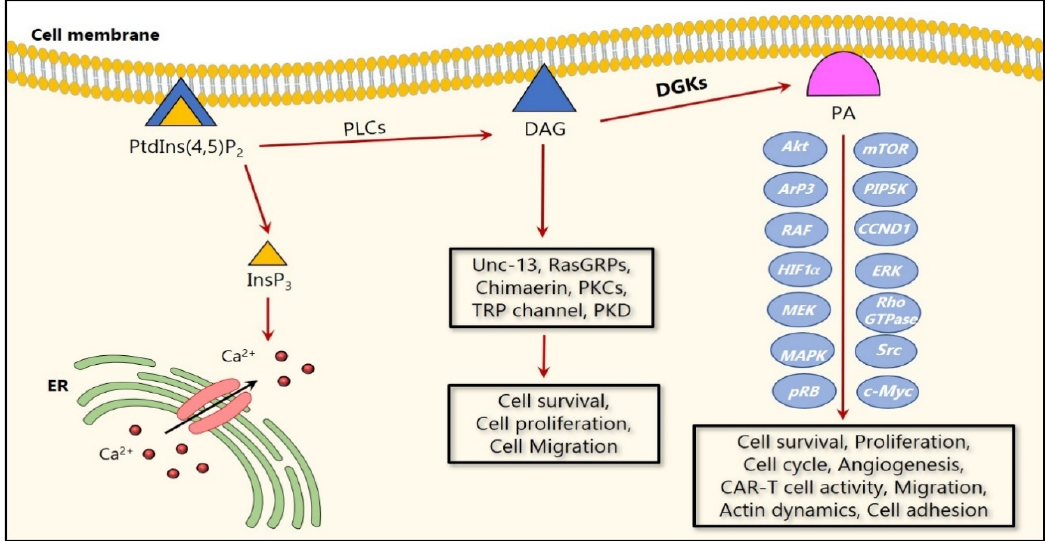
Figure 1. Cartoon representation of DGK signaling in cancer. Upon their activation, DGKs phosphorylate DAG to form PA, which results in a series of signaling events resulting from the alterations in the signaling of several molecular targets. Several studies reported that DGKs regulate cancer cell survival and proliferation via MAPK and Akt/mTOR pathways. In addition, DGKs regulate migration via the Ras/RAF/MEK/ERK pathway and the Rho GTPase family members. On the other hand, DAG activates several critical proteins including both conventional and novel PKCs, mammalian Unc-13, chimaerins which activate Rac GTPase, and RasGRPs, which are involved in cell proliferation and migration.